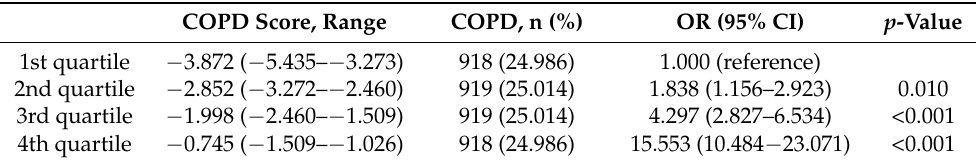
Table 4. Performance of the COPD score in the validation cohort. COPD Score, Range COPD, n (%) OR (95%